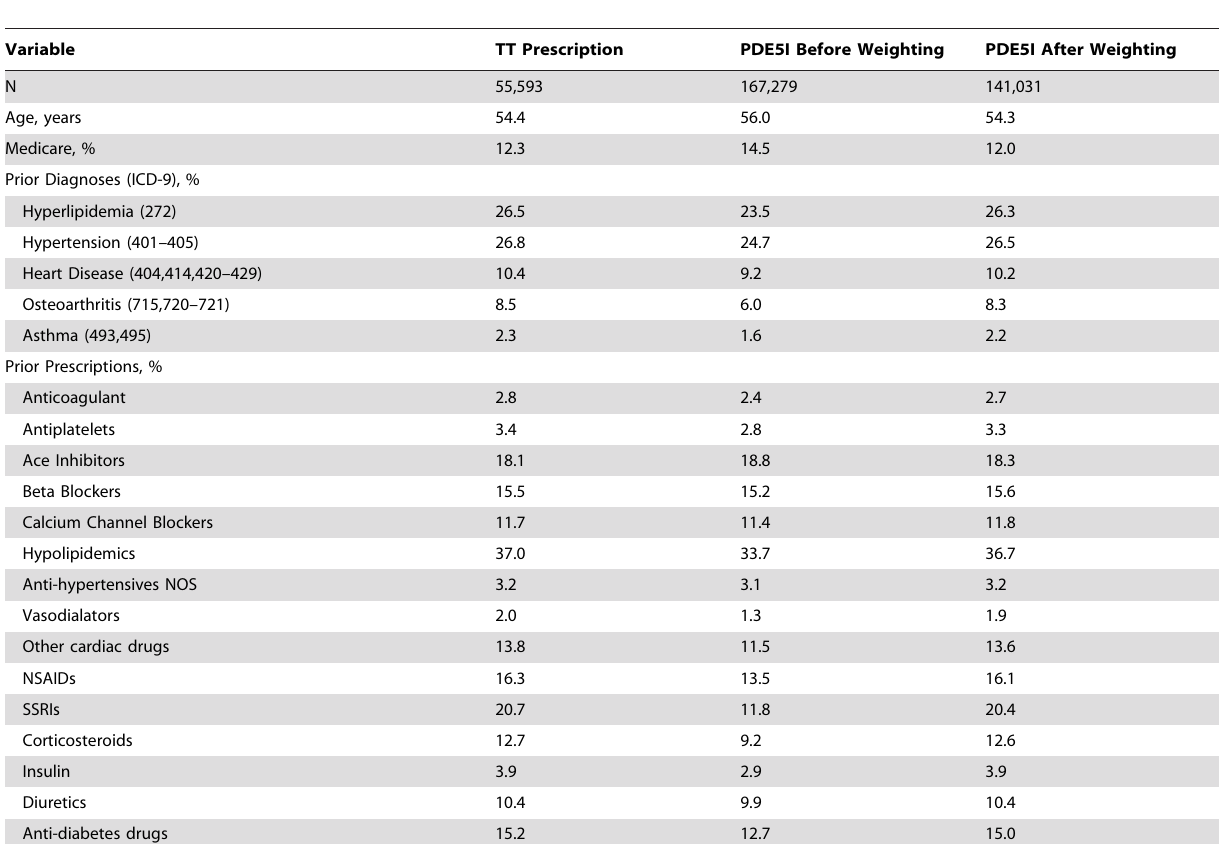
Table 2. Distribution of baseline covariates for all Medicare and commercial insurance enrollees in the TT prescription and PDE5I cohorts before and after